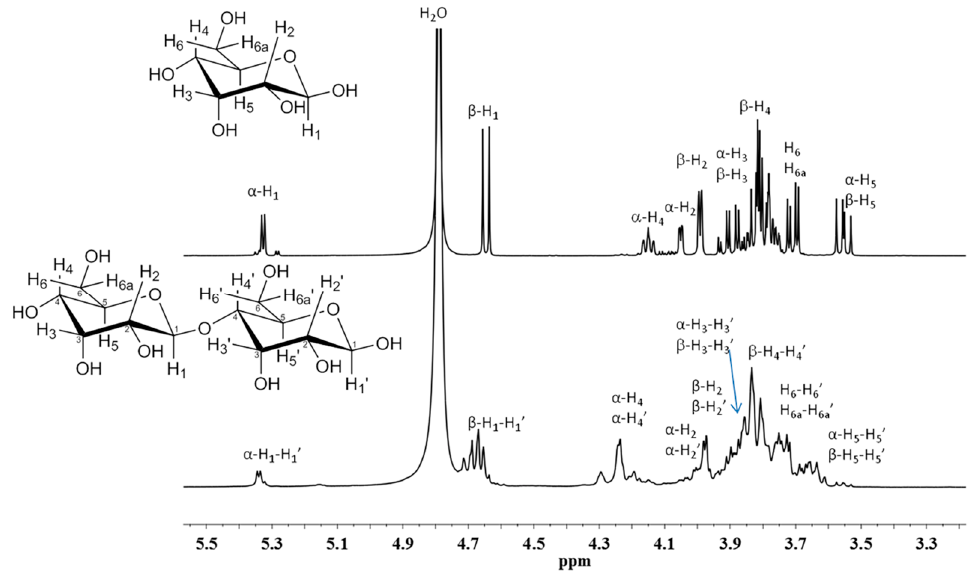
Figure 7. Proton nuclear magnetic resonance ( 1 H-NMR) spectra of galactose standard and PGOs produced via enzymatic hydrolysis with C. japonicus enzyme.